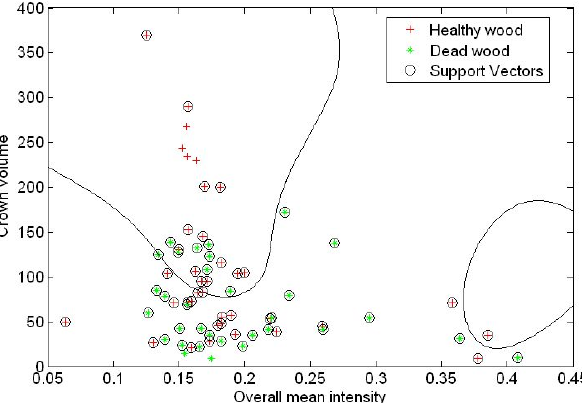
Figure 4. 2D feature space as an example to undergo SVM classification of discriminating between dead and living trees, the black lines indicate the SVM nonlinear decision